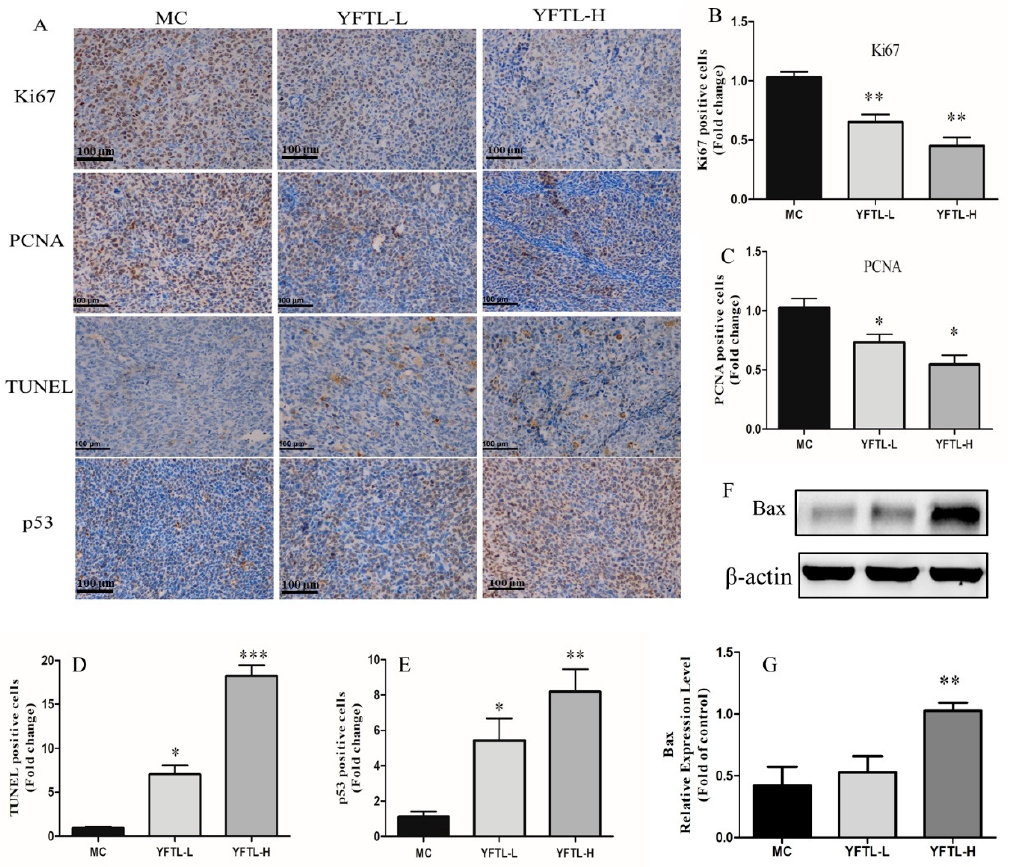
Figure 2. H&E, TUNEL and immunohistochemical assay of Lewis tumors. ( A ) Representative photomicrographs of H&E staining, TUNEL assay and immunohistochemistry of Ki67, PCNA, and p53 in tumor tissues. Scale bars are 100 µ m. (B) Relative level of Ki-67 in tumor tissues. ( C ) Relative level of PCNA in tumor tissues. ( D ) Quantification of the numbers of TUNEL-positive cells. ( E ) Relative level of p53 in tumor tissues. ( F ) A representative band of Bax protein expression by Western blot analysis. (G) Relative protein level of Bax in tumor tissues. Data are expressed as a histogram of mean ± SD of three independent experiments, * p < 0.05, ** p < 0.01, and *** p < 0.001 vs. the MC group.